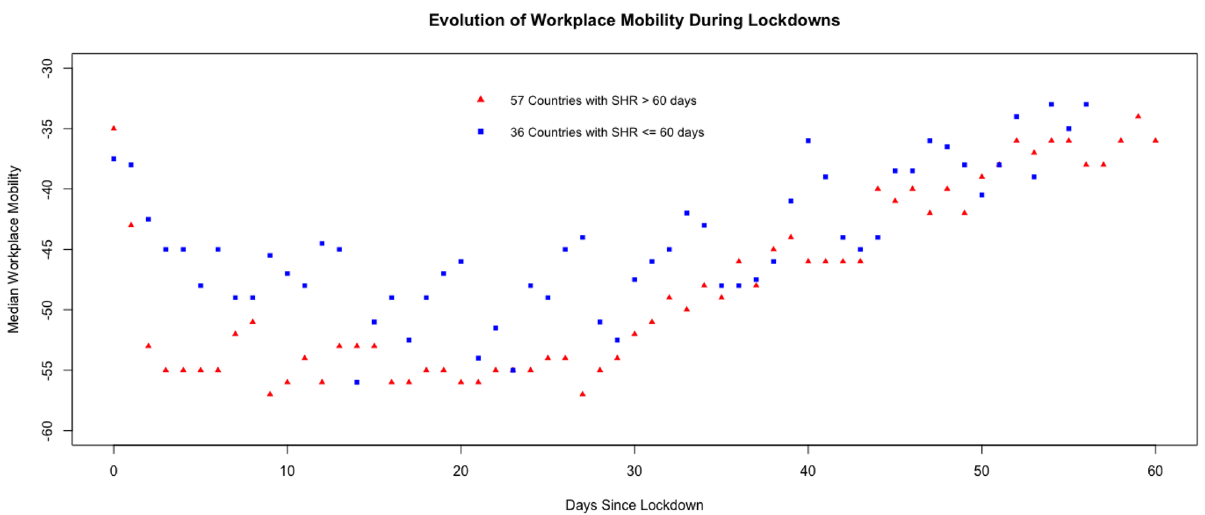
Figure 3. Evolution of workplace mobility during lockdowns. For each country (n = 93), we identify the date when the first lockdown ( SHR stay at home requirement) was imposed over its general population. We separate countries by whether the imposed lockdown ≤ 60 days (blue squares) or > 60 days (red triangles). During the lockdown period, for each day since the start of the lockdown we determine the median workplace mobility across countries within each set for that